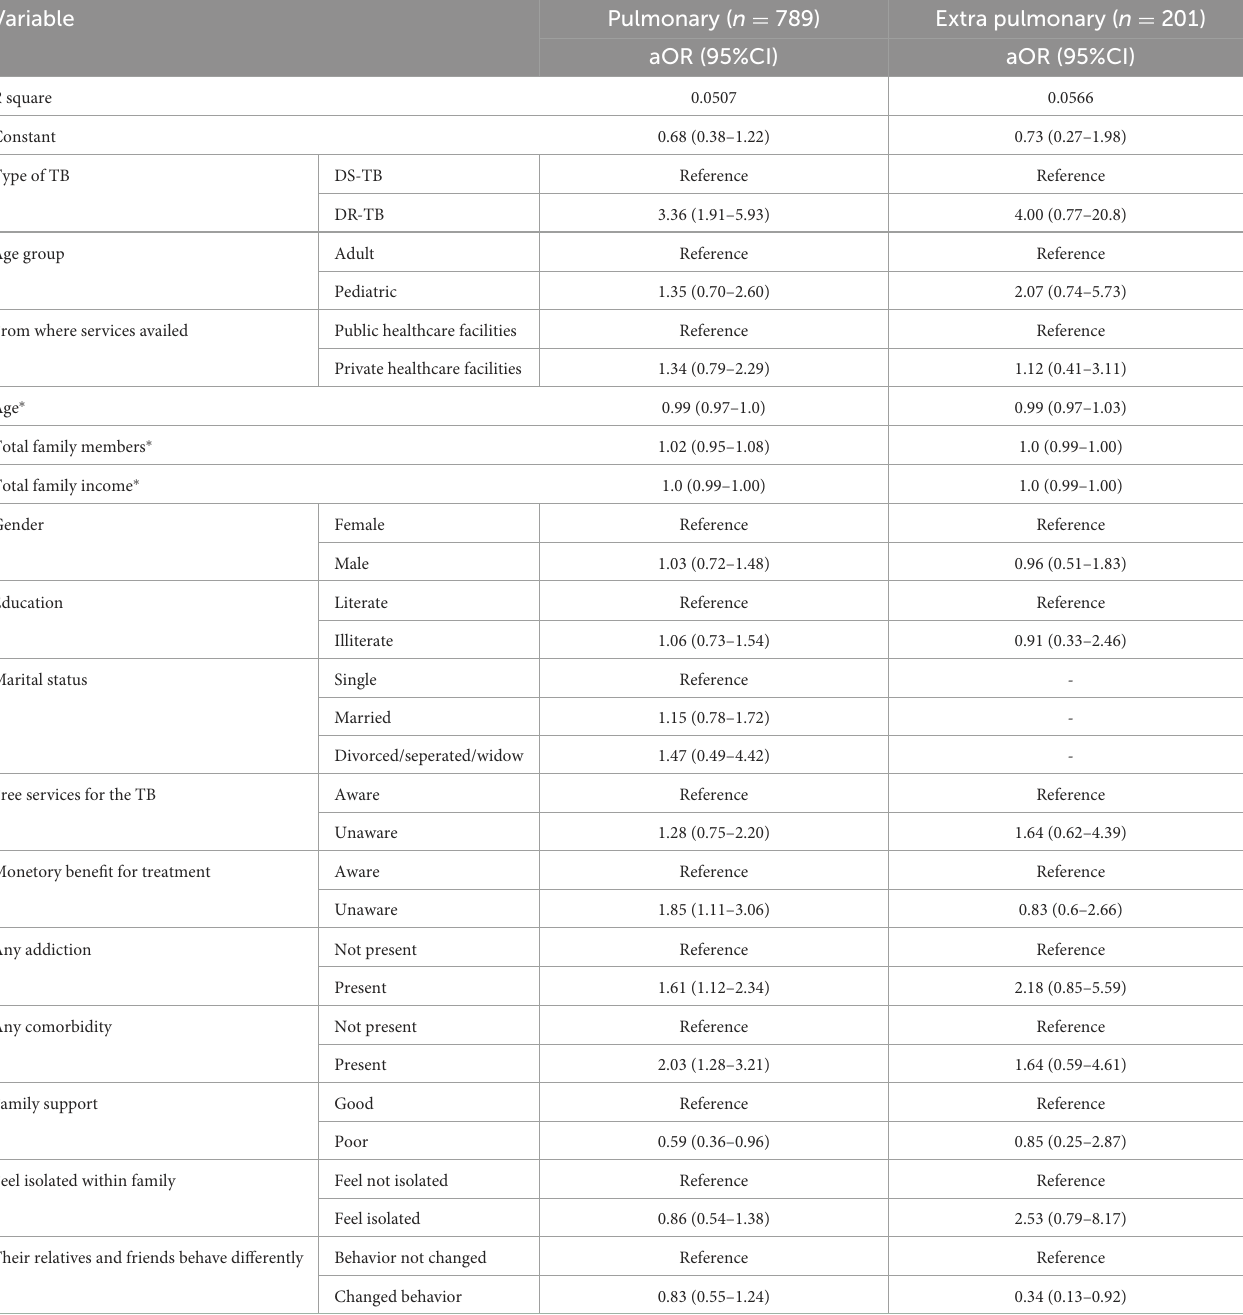
TABLE 6 Factors contributing to the total delay in various groups of TB